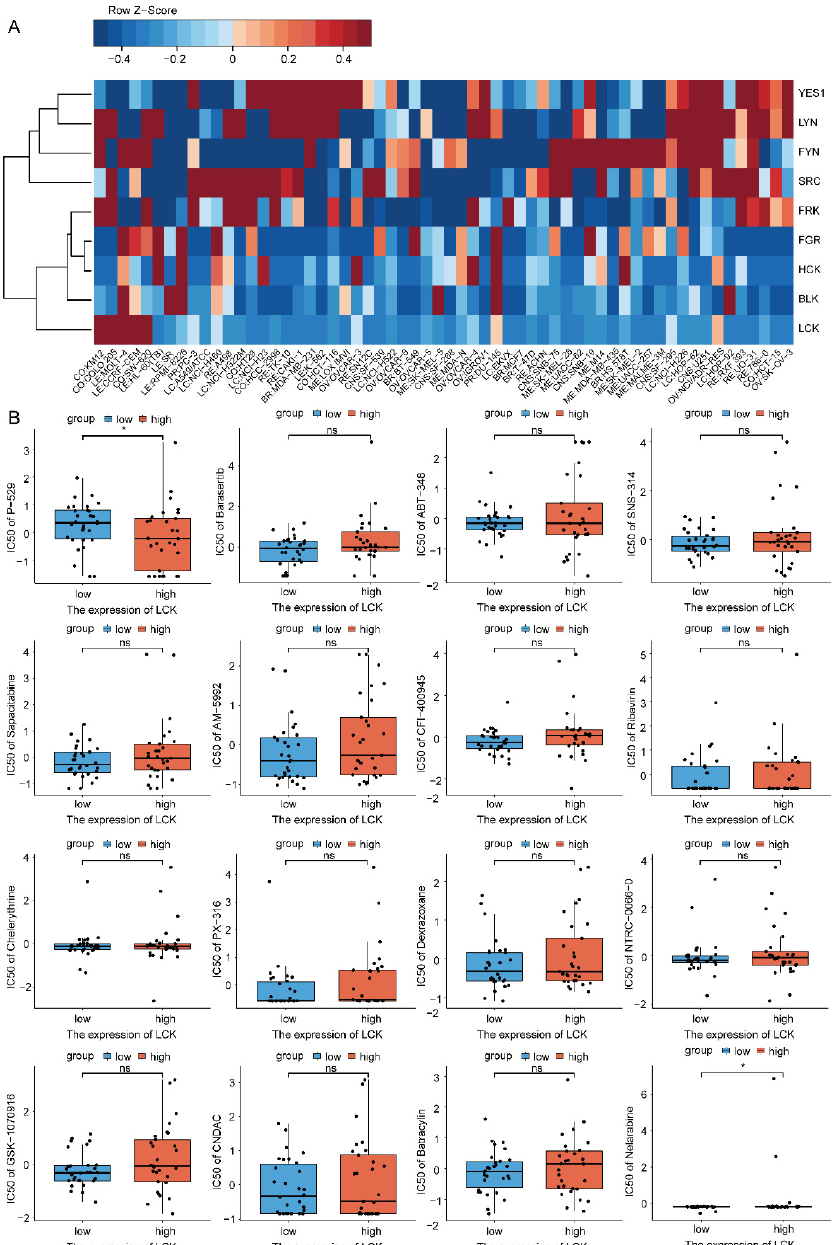
Figure 9. Drug sensitivity of LCK based on the CellMiner databases. (* p < 0.05). ( A ) The correlation between mRNA expression level of Src kinase family members and their corresponding z scores of cell sensitivity after drug treatment based on 60 cancer cell lines were exhibited with heatmap. ( B ) Box plots exhibited the top 16 correlations between LCK and drug sensitivity based on IC-50.